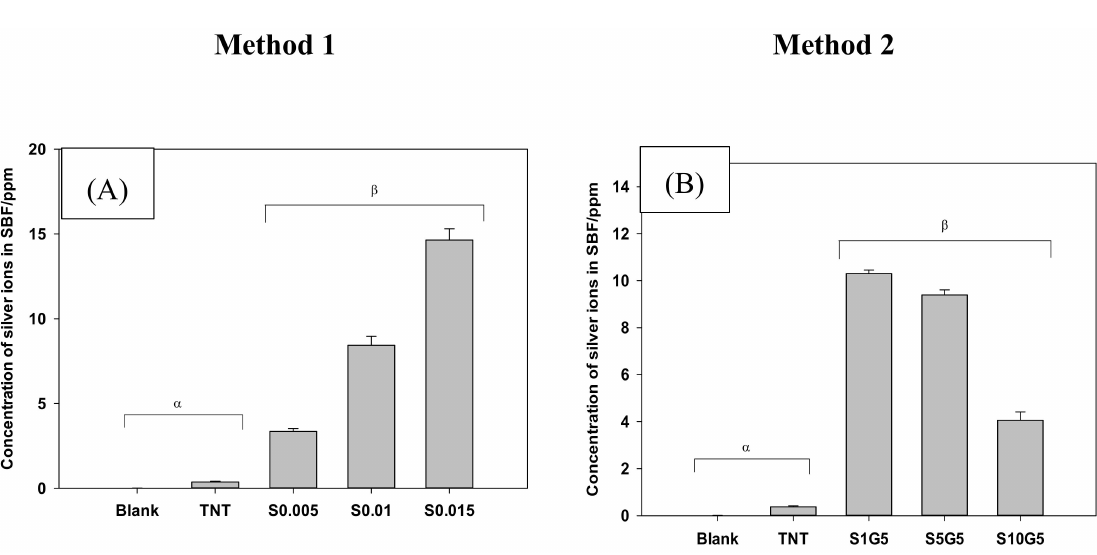
Figure 8. ICP analysis of acidified simulated body fluid (SBF) after 24 h exposure of samples from ( A